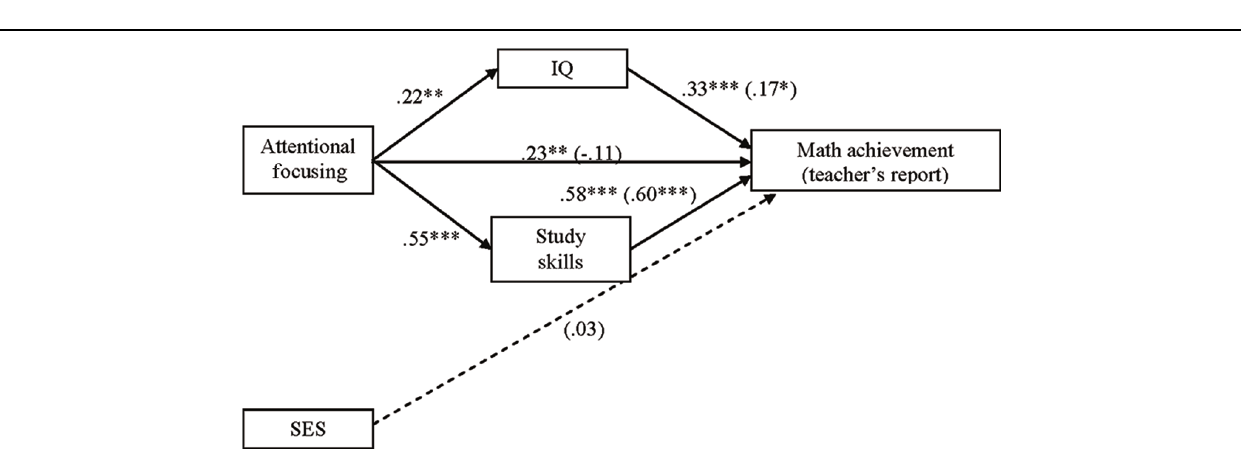
Frontiers in Psychology |